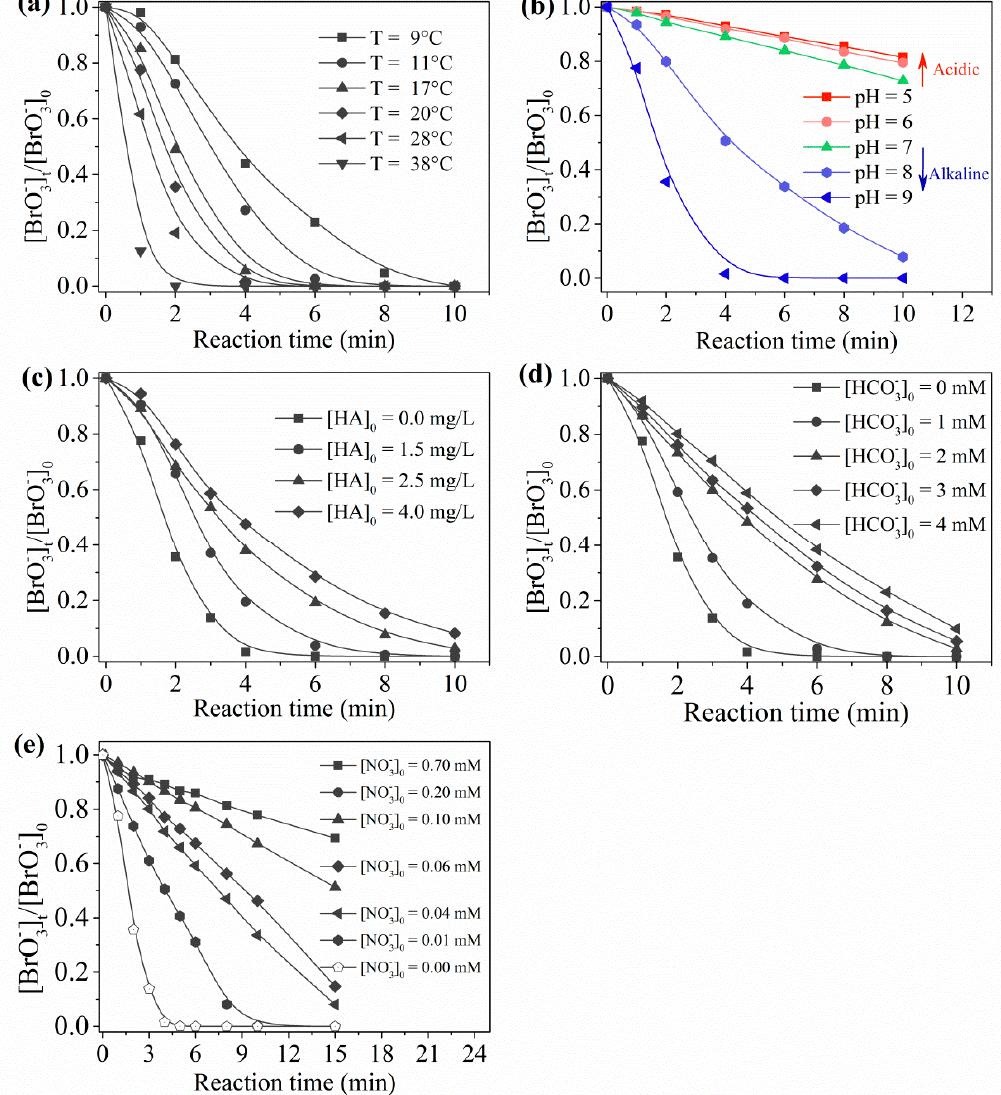
Figure 7. Influence on water quality parameters with regards to the degradation of BrO (cid:2871)(cid:2879) using the UV/sulfite/ I (cid:2879) process: ( a ) temperature; ( b ) pH; ( c ) humic acid (HA); ( d ) HCO (cid:2871)(cid:2879) ; ( e ) NO (cid:2871)(cid:2879) . Conditions: [ BrO (cid:2871)(cid:2879) ] 0 = 10 μ M, [ I (cid:2879) ] 0 = 100 μ M, [sulfite] 0 = 1.0 mM, [DO] 0 = 7.0 mg·L − 1 , pH = 9.2, 20 ± 1